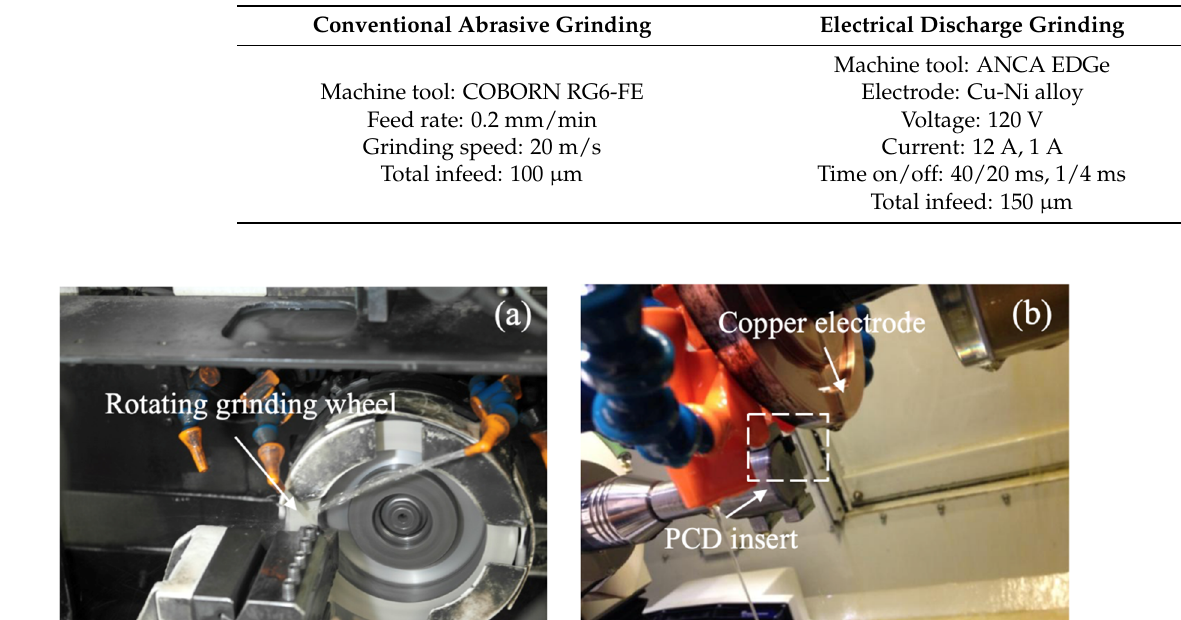
Figure 2. ( a ) Abrasive grinding of polycrystalline diamond (PCD) on COBORN RG6-FE. ( b ) Electrical discharge grinding (EDG) of PCD on ANCA EDGe. Table 1. Basic physical properties of polycrystalline diamond (PCD) tool materials [28].